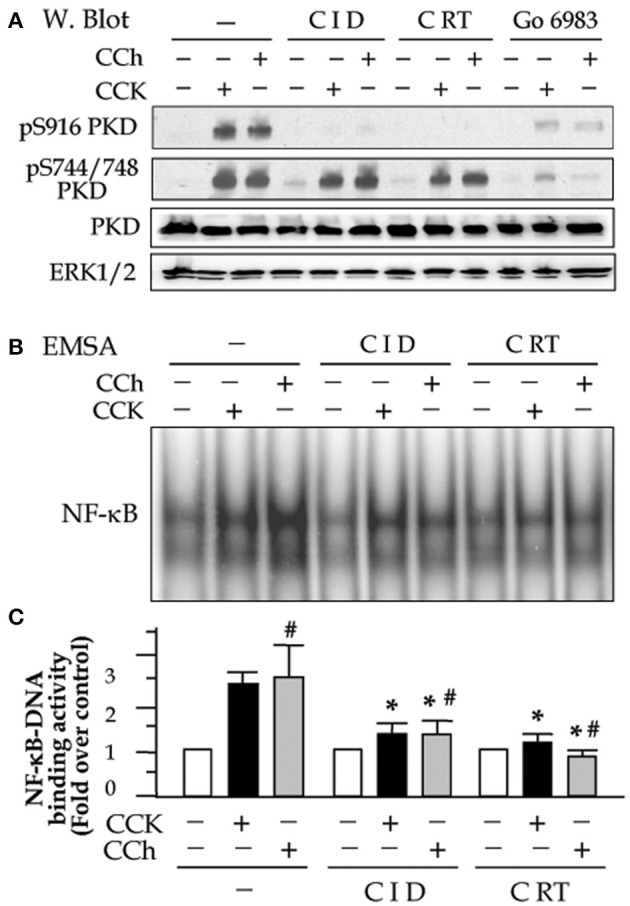
Small molecule chemicals CID755673 and CRT0066101 inhibit high dose secretagogue-induced PKD activation and NF-κB activation in pancreatic acinar cells. Rat pancreatic acinar cells were incubated with or without CID755673 (CID, 25 μM) or CRT0066101 (CRT, 10 μM) and PKC inhibitor Go6983 (10 μM) for 2 h prior to 100 nM CCK or 200 μM CCh treatment for an additional 30 min. (A) Western blot was performed to analyze PKD phosphorylation in cell lysate. PKD and ERK1/2: for loading controls. (B) NF-κB-DNA binding activity was measured in cell nuclear extracts (NE) by EMSA. (C) NF-κB band intensities were quantified in the PhosphorImager and normalized on the band intensity in unstimulated control acini. Values are means ± SE (n = 3). *p < 0.05 vs. CCK or CCh (#) alone without inhibitor pre-treatments.